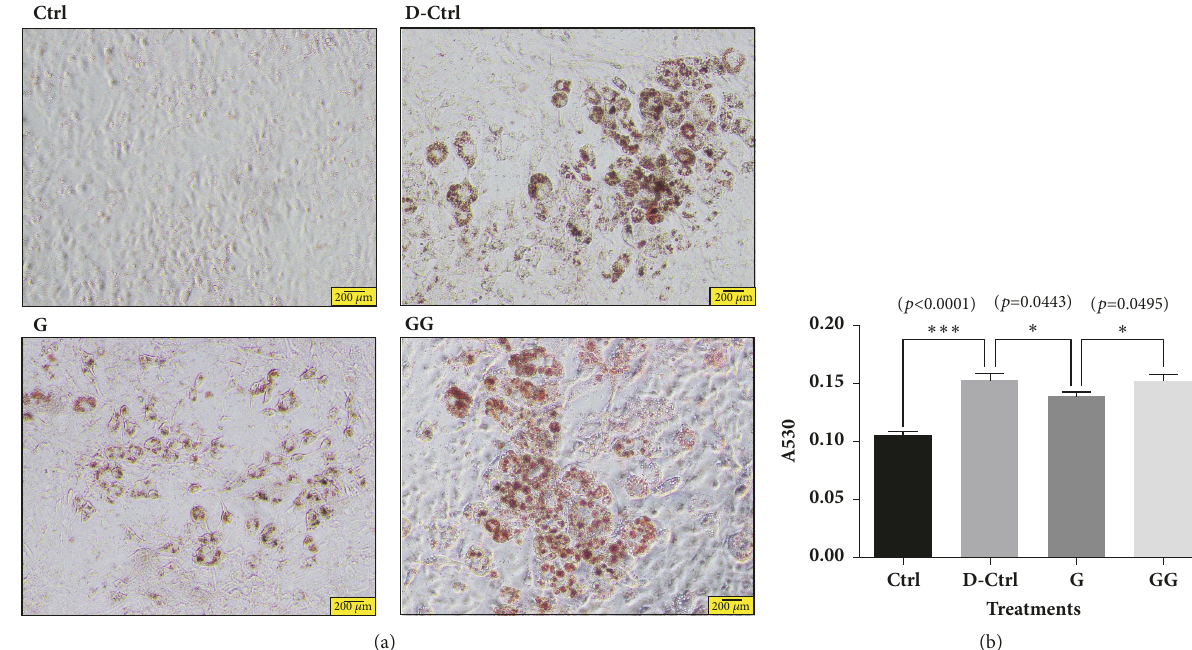
Figure 6: Oil Re d O stainin g in d i ff erentiate d 3 T 3 - L1 cells treate d w it h 6 - g in g er o l an d GS K0660 . (a, b) 6-Gingerol decreased the lipid accumulation in differentiated 3T3-L1 cells compared to differentiation control. In addition, the effect of 6-gingerol was revered by PPAR 𝛿 antagonist. Magnification is 200 times. The results are expressed as means ± SEM (n=3). Values were statistically analyzed by unpaired t -test. All experiments were repeated three or more times. The statistical significance between the two experimental groups was marked as ∗ p < 0.05 and ∗ ∗ ∗ p < 0.001. Meaning of indications: Ctrl means untreated normal control group, D-Ctrl means differentiation control group without treatment, G means 6-gingerol treated group during differentiation, and GG means 6-gingerol and GSK0660 treated group during